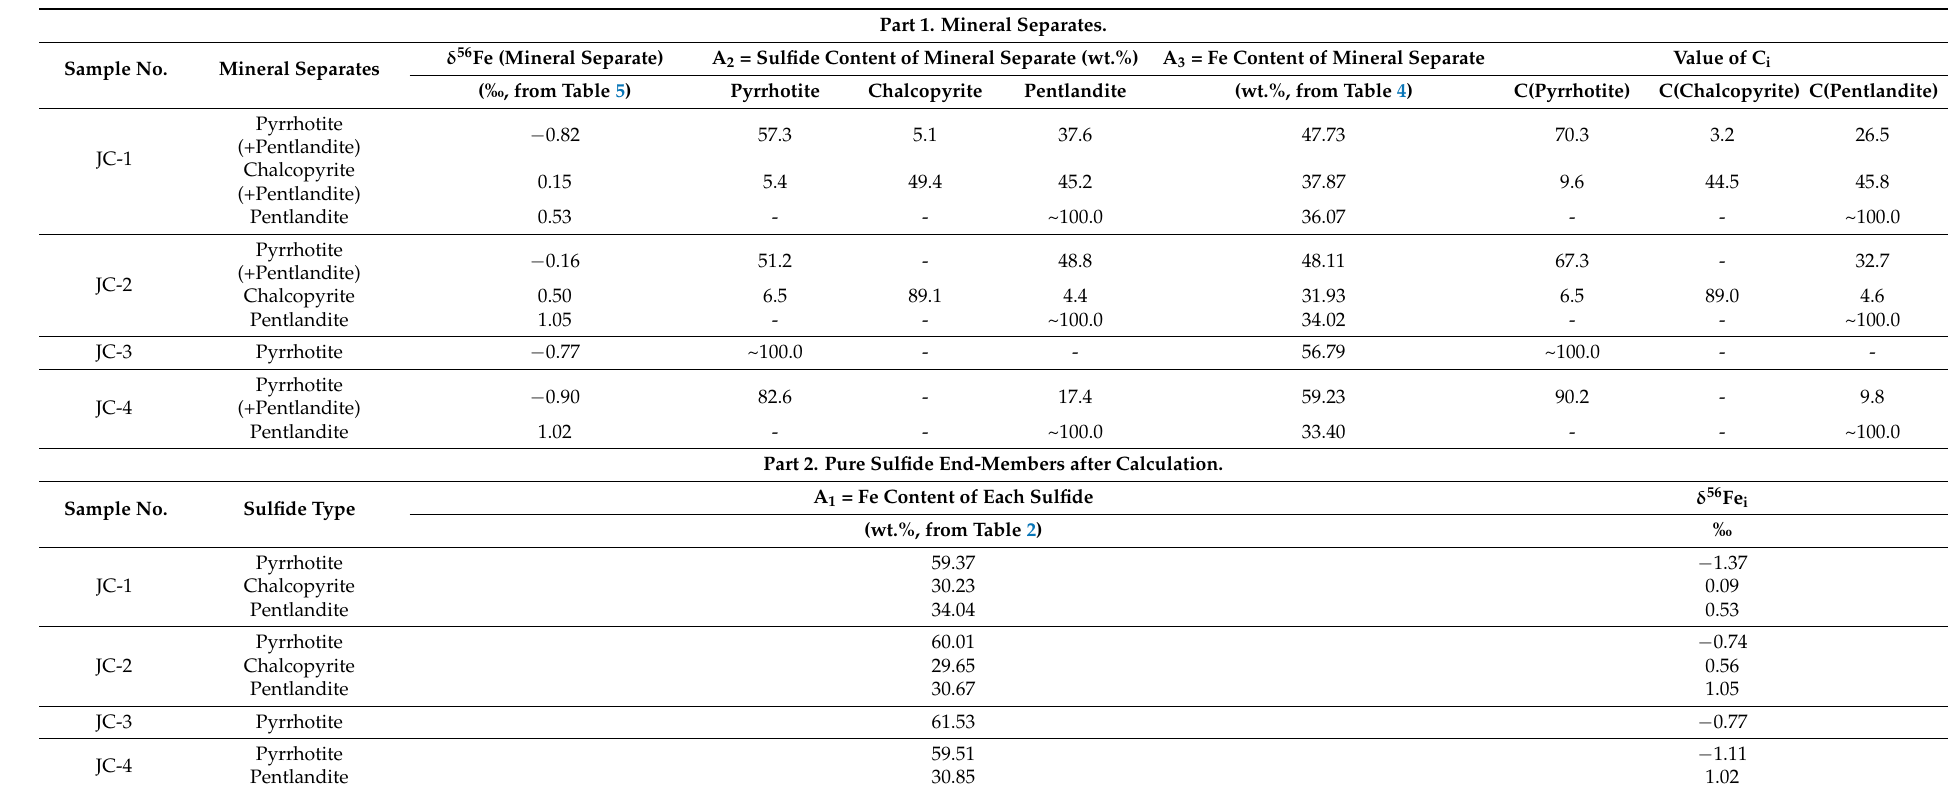
Table 6. Calculation of iron isotope composition of pure sulfide end-members in net-textured sulfide ore samples. Part 1. Mineral